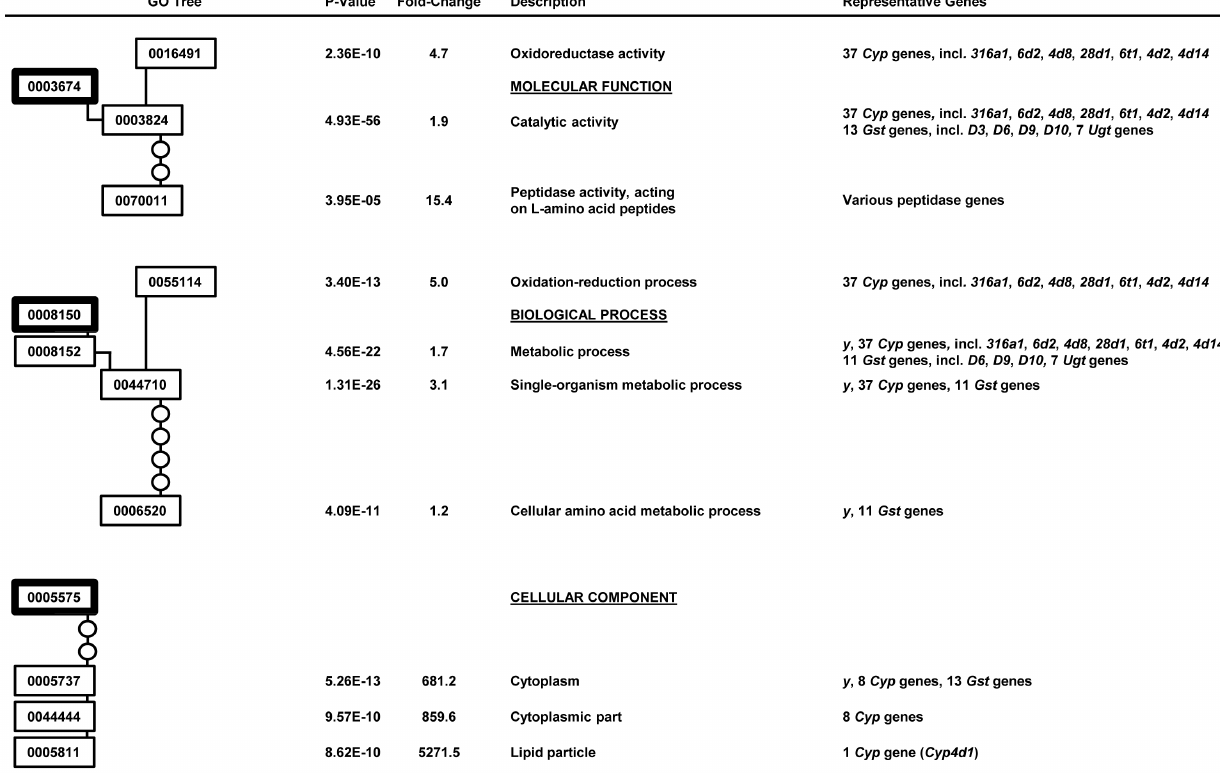
Figure 5. Gene ontology enrichment analysis for Ama-KTT/M/2 on a -amanitin versus Ama-KTT/M/2 on no toxin (group 3 versus 2). The GO trees for the molecular function, biological process, and cellular component are shown on the left-hand side with the numbers for each term. The corrected p-values, average fold-changes for all genes in each term, term names, and selected genes of each GO term are shown on the right- hand side of each term number.